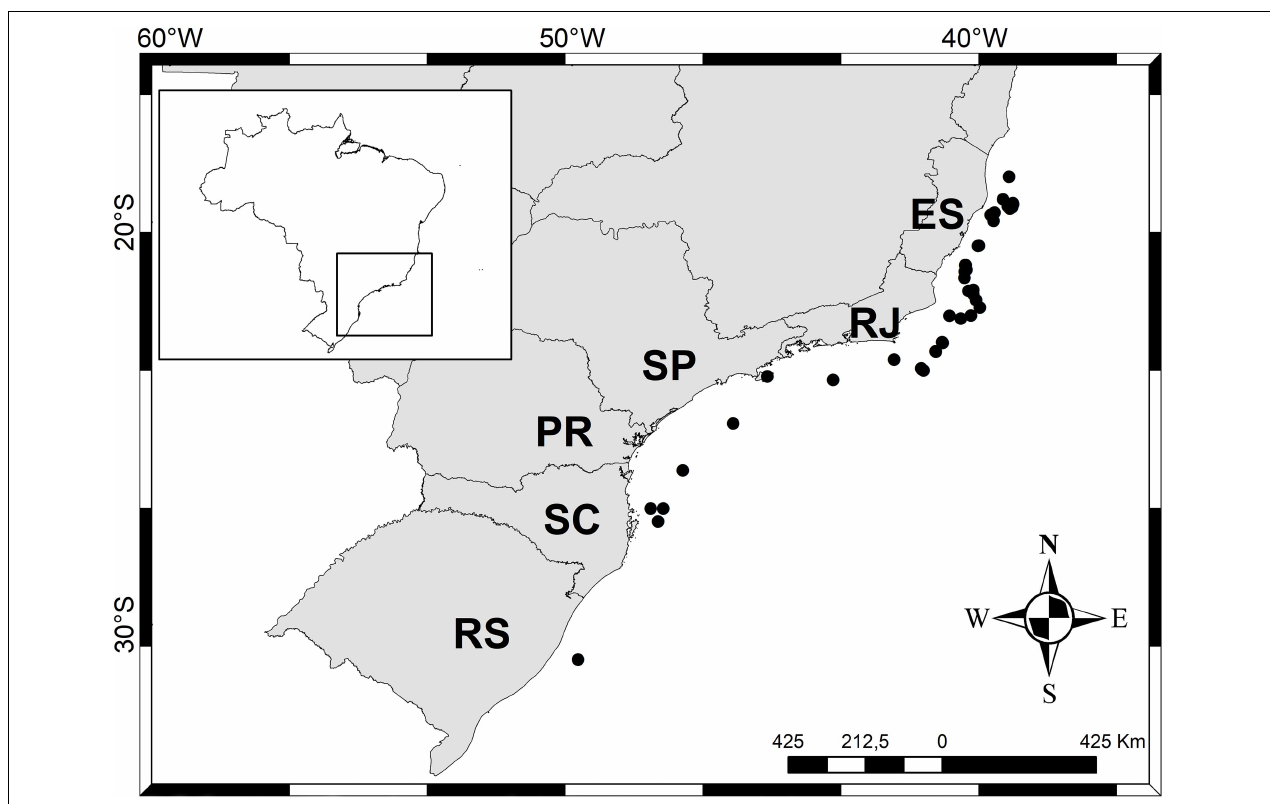
FIGURE 6 | Scutopus variabilis sp. nov. Distribution of this species along the States of the Southeastern and Southern Brazilian